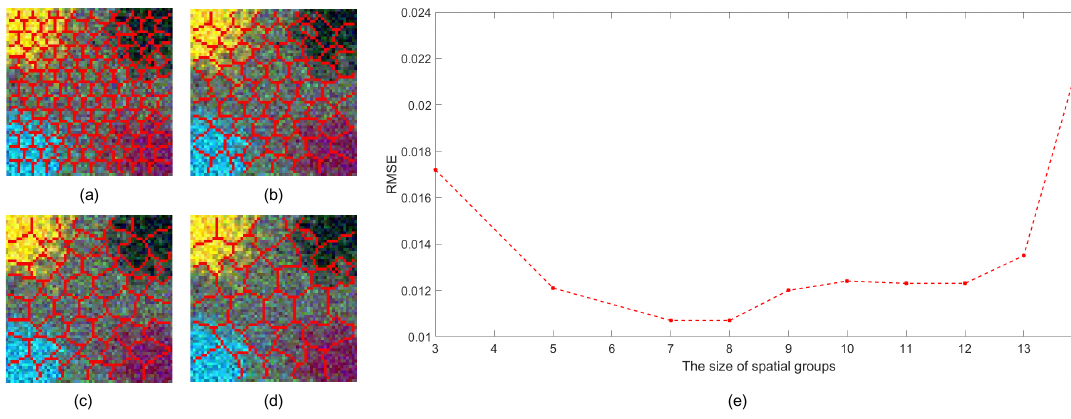
Figure 15. Performance analysis of SGSNMF with respect to different size superpixels. ( a ) w = 5. ( b ) w = 7. ( c ) w = 9. ( d ) w = 11. ( e ) RMSE of abundance values with respect to w .